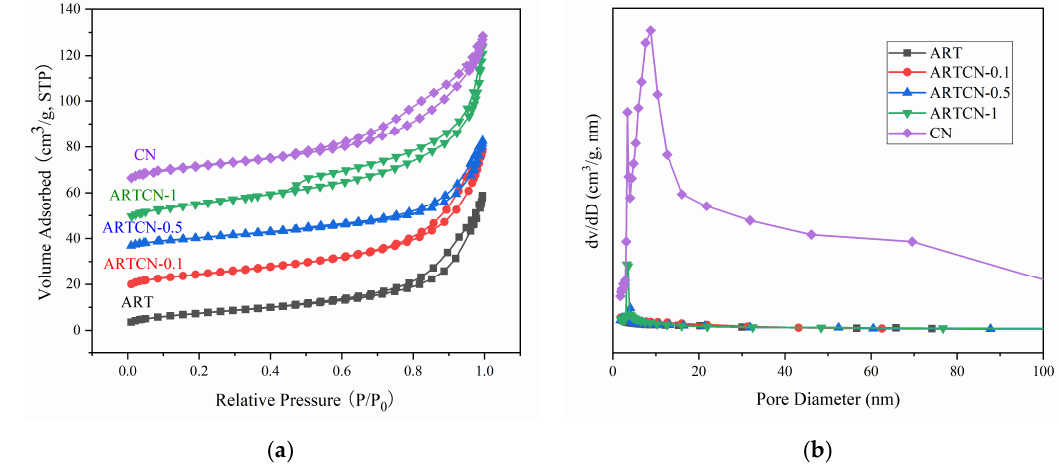
Figure 3. SEM images of CN ( a ), ART ( b ), and ARTCN-0.5 ( c ); images and corresponding EDS ele-